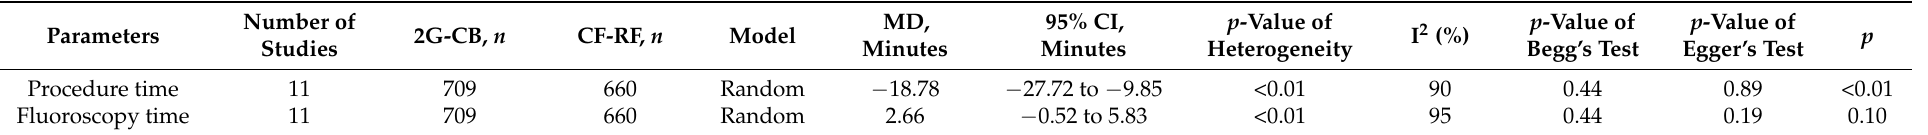
Table 4. Summary of the procedural time and fluoroscopy